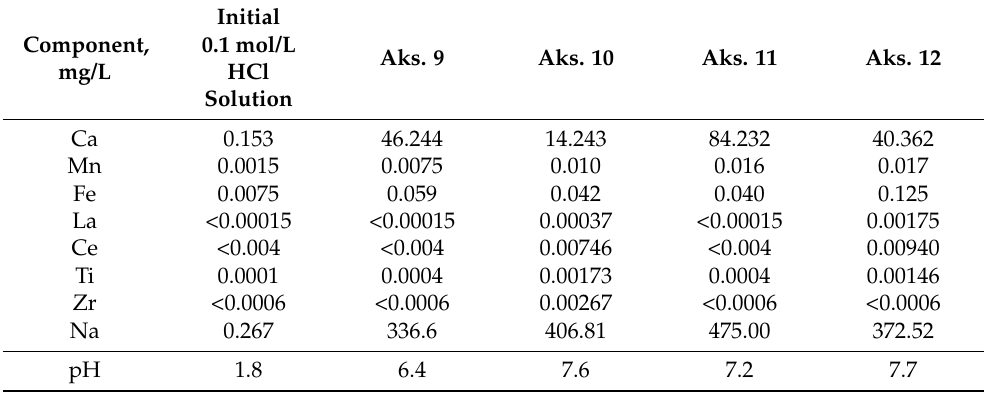
Table 8. Chemical composition (mg/L) and pH of both initial solution and solutions after experiments with 0.1 mol/L HCl